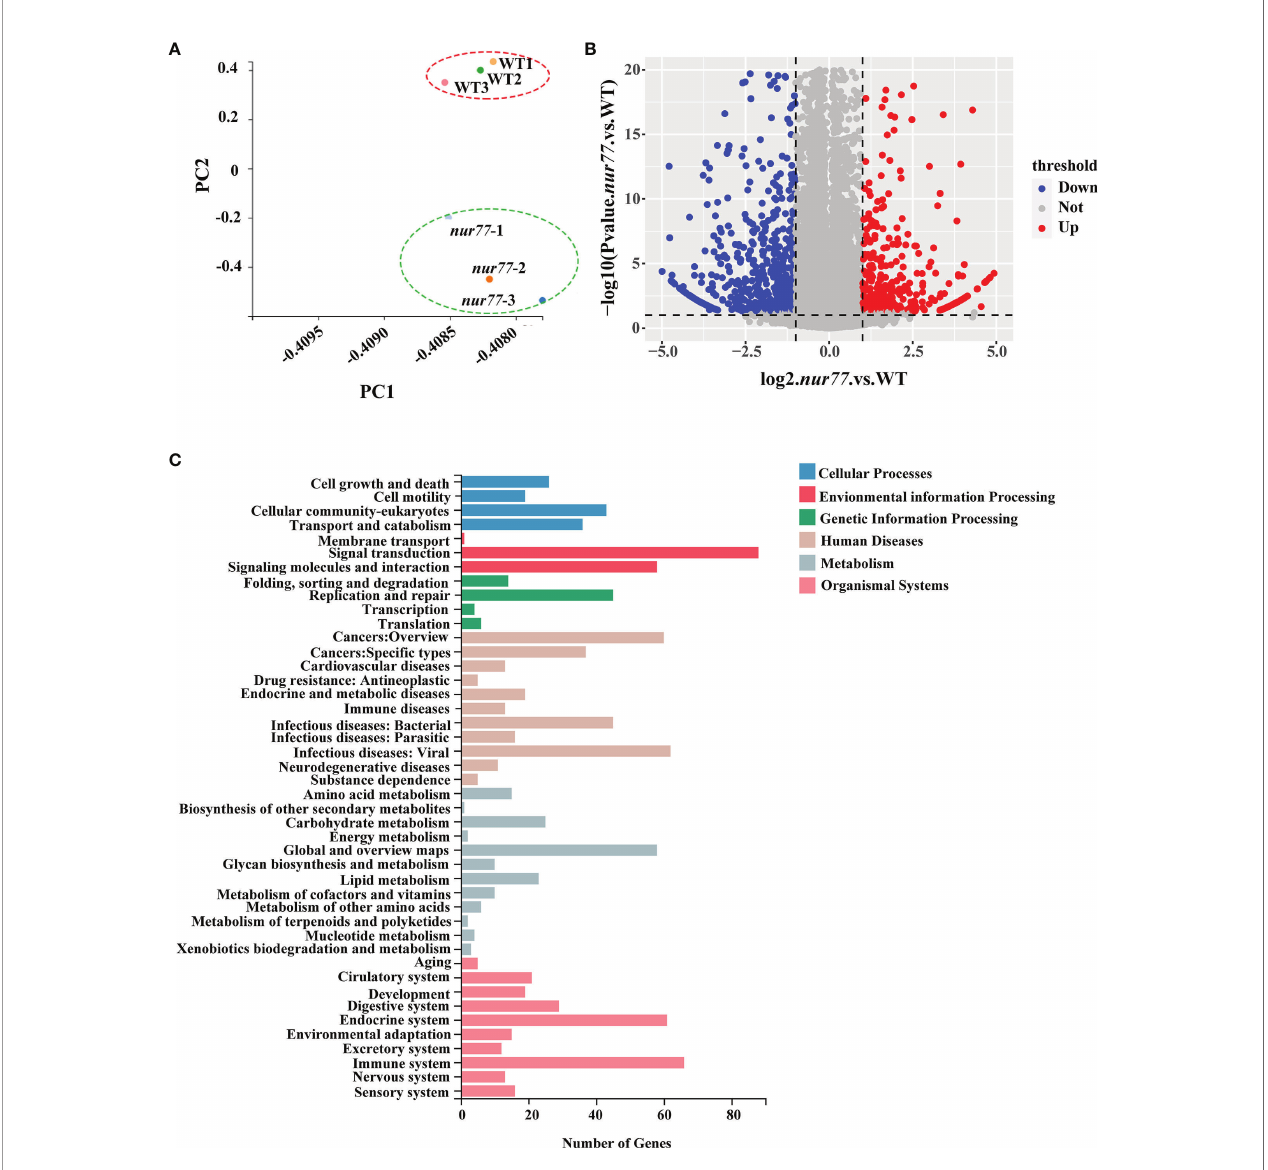
FIGURE 2 | RNA-seq (RNA sequencing) analysis of nur77 − / − mutant zebra fi sh. (A) Principal component analysis (PCA) plot of three wild-type and three nur77 − / −